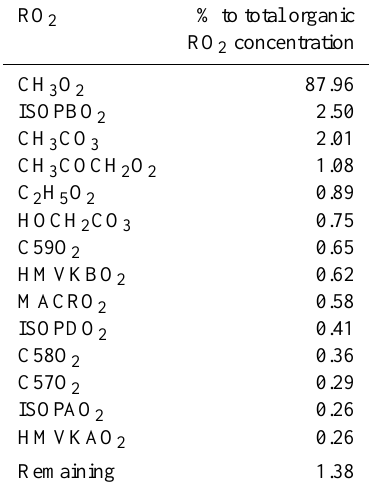
Table 2. Organic RO 2 speciation from DSMACC during the in- tercomparison period. Species names are from the MCM. Note that ISOPAO 2 , ISOPBO 2 , ISOPDO 2 , C57O 2 , C58O 2 , C59O 2 , HMVKAO 2 , HMVKBO 2 and MACRO 2 are all derived from iso- prene and its oxidation